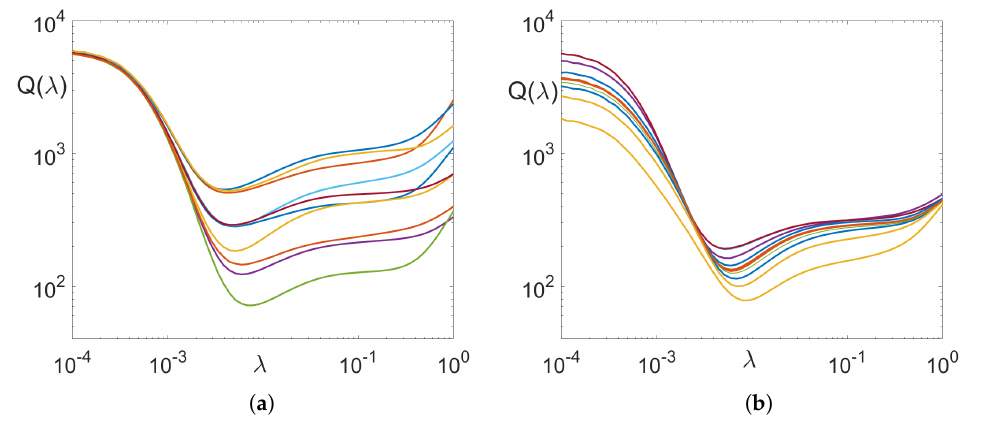
Figure 1. Deblurring Error for ( a ) single kernel, different images; ( b ) single image, various kernels.